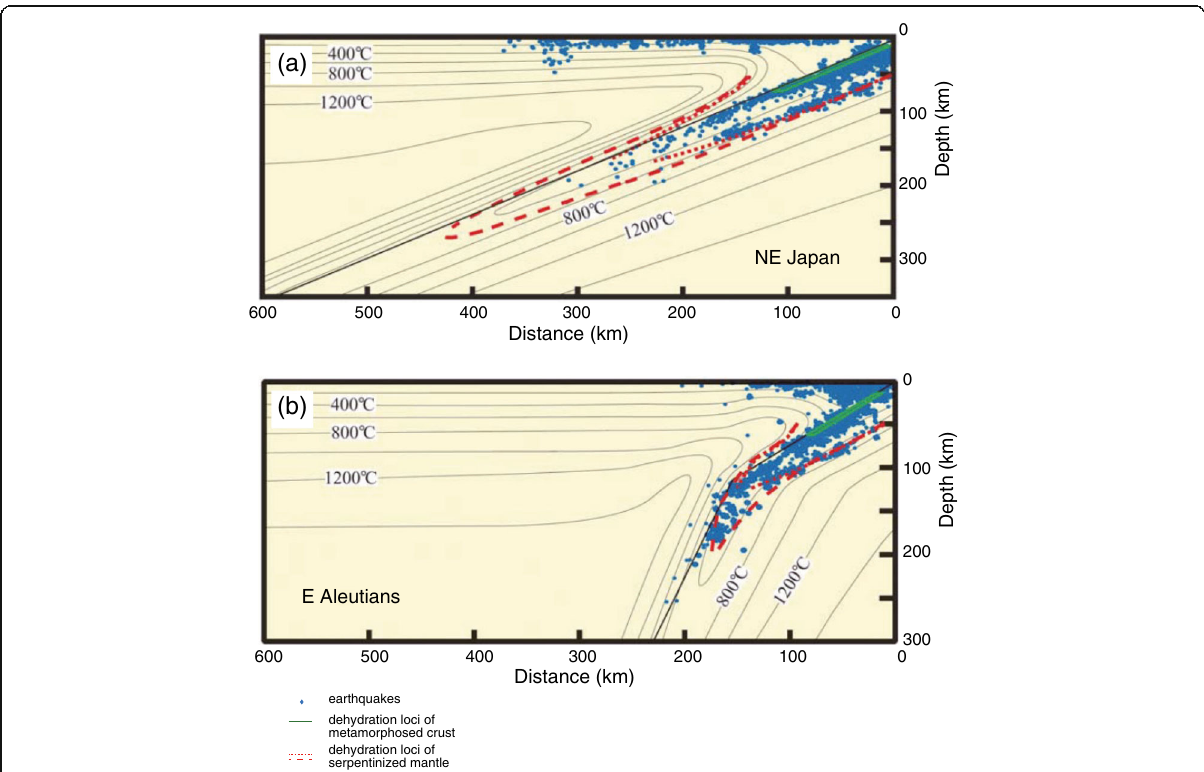
Fig. 5 Across-arc vertical cross-sections of intraslab earthquakes and dehydration loci in the slabs. a Tohoku and b eastern Aleutian subduction zones. Dehydration loci of metamorphosed crust and serpentinized mantle are indicated by the green and red lines , respectively. Red broken lines and red dotted lines are those based on the antigorite reaction boundaries of Ulmer and Trommsdorff (1995) and Wunder and Schreyer (1997), respectively. Blue dots are earthquakes. Thermal structure is shown as isothermal contours. (After Yamasaki and Seno,